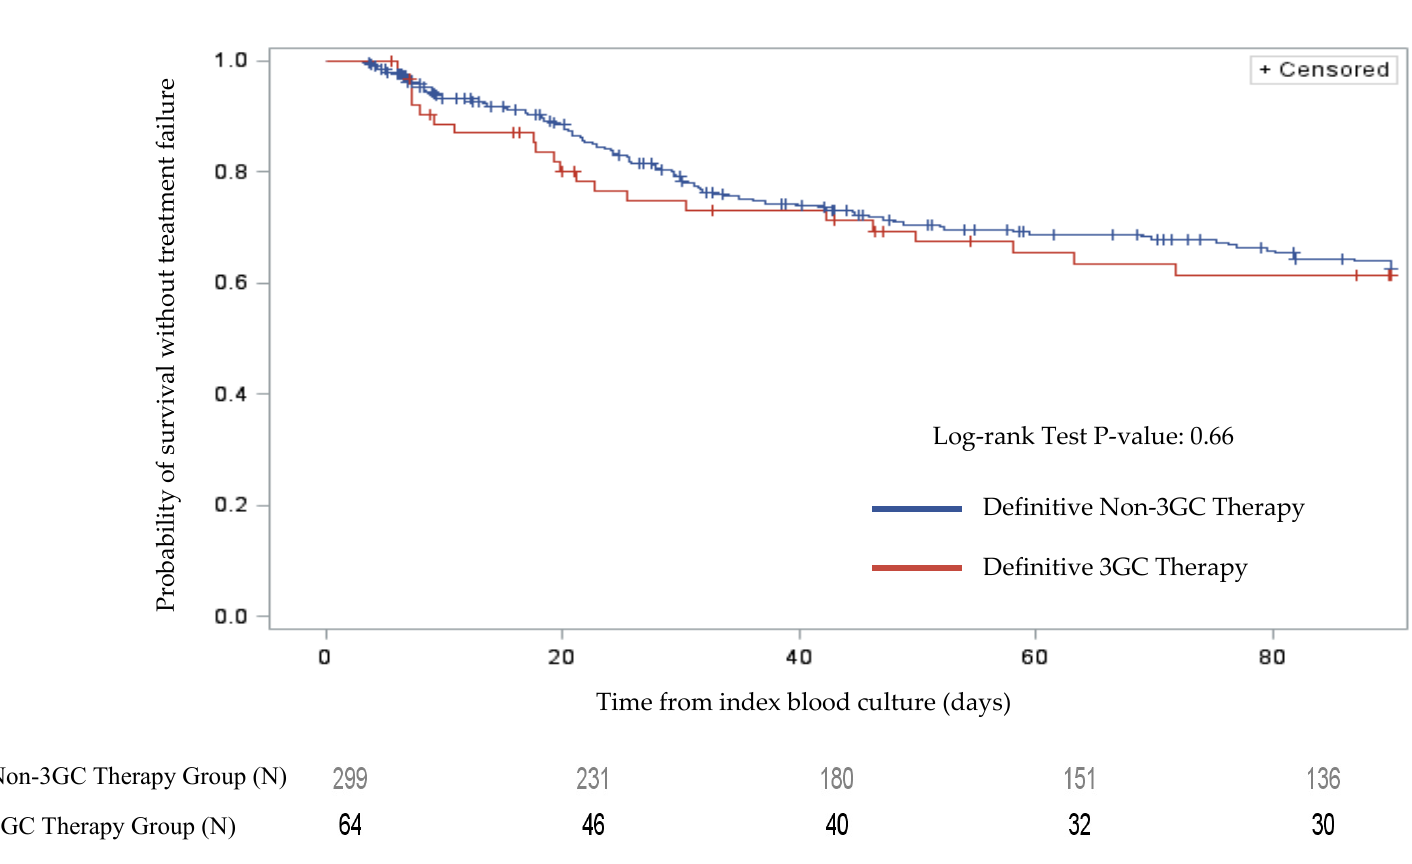
Figure 2. Kaplan–Meier curves for overall treatment failure by therapy group. The red line represents patients on definitive third-generation cephalosporins, and the blue line represents patients on other definitive antibiotics.